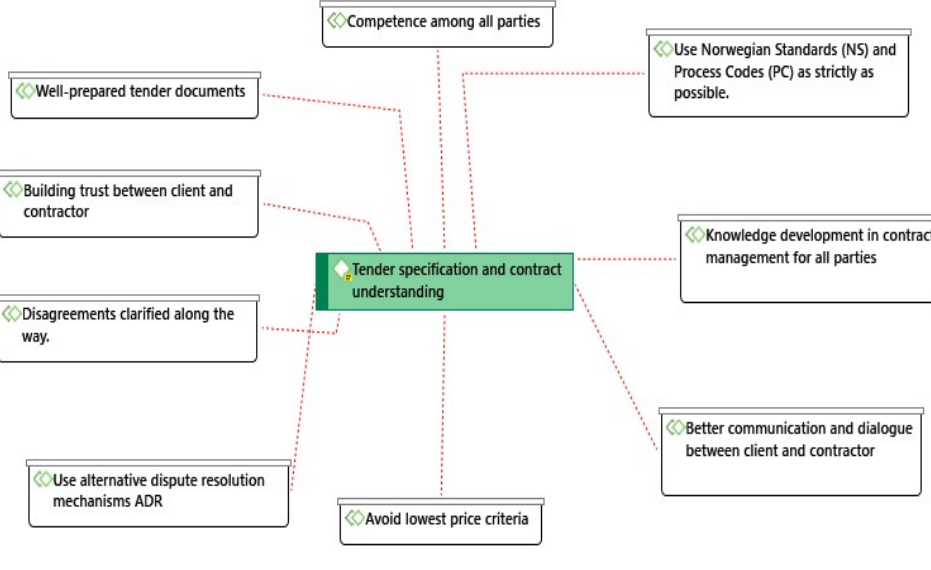
Figure 4. Thematic map 1.